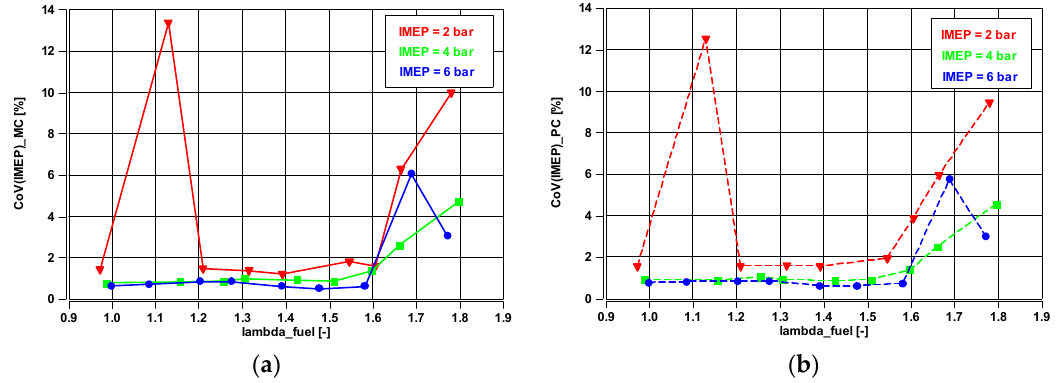
Figure 12. Non-uniformity of the indicated mean engine pressure for different values of fuel mix- ture leanness: ( a ) in the main chamber; ( b ) in the prechamber.